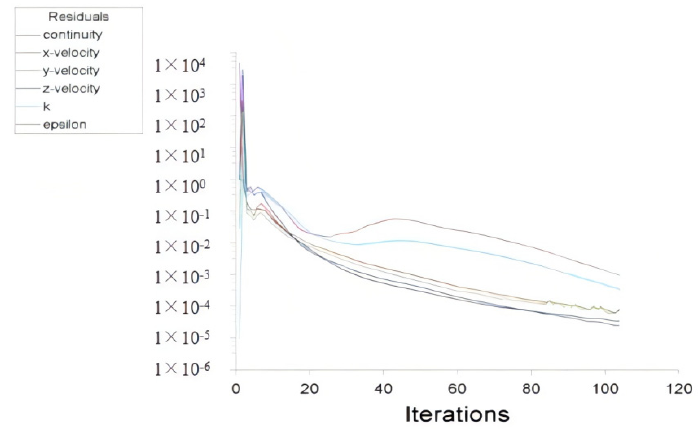
Figure 11. Convergence curve of iterative computations.